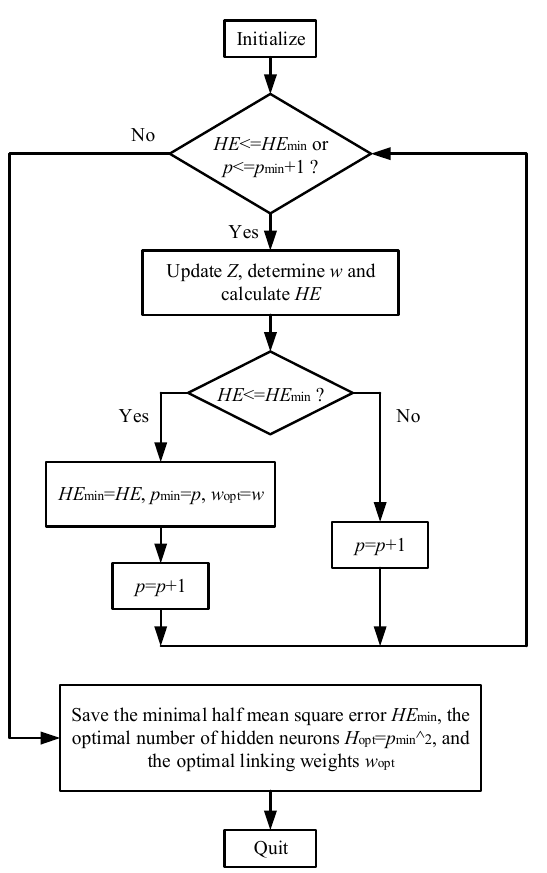
Figure 5. Flowchart of structure determination algorithm of Chebyshev polynomial of Class 1 neural network.